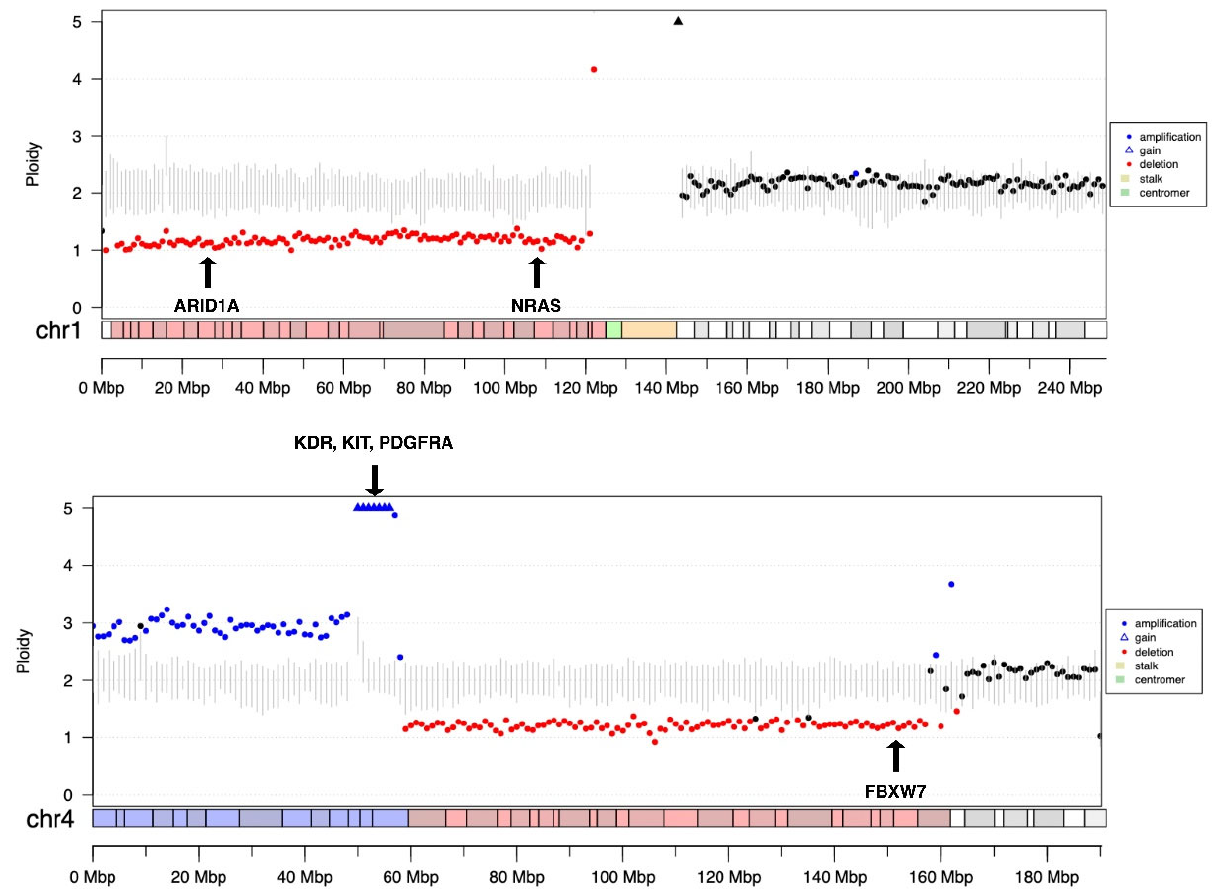
Figure 2. CNAs detected via ulcWGS. Chromosome (Chr.) plots generated by CORIANDR for Chrs. 1 and 4 of a patient with sarcoma. Amplifications of KDR, KIT and PDGFRA were confirmed by ulcWGS on chromosome 4 (add(q)12), as reported by VP analyses. Additionally, the ulcWGS detected a heterozygous deletion of chromosome 1p (including the region of the ARID1A gene, not target by VP, and NRAS gene, heterozygous deletion also detected by VP) and a partial loss of Chr. 4q (a partial loss of FBXW7 gene with Copy Number (CN) of 0.62 was also reported by VP assay). Other low-level CN gains and losses detected via VP and ulcWGS are displayed in Supplementary Materials Figure